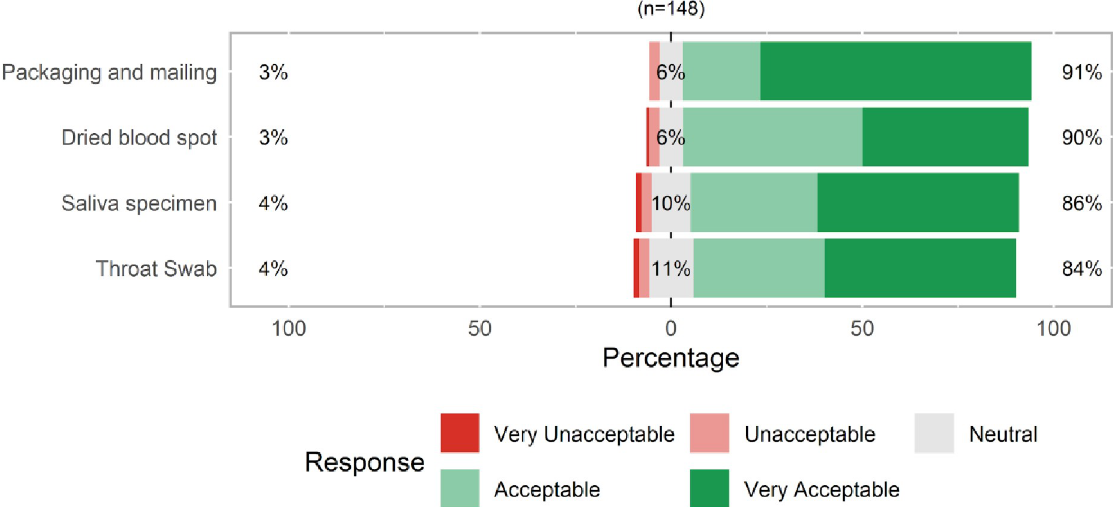
Fig 1. Acceptability of at-home collection, packaging and mailing specimens for SARS-CoV-2 related testing, United States, April 2020.